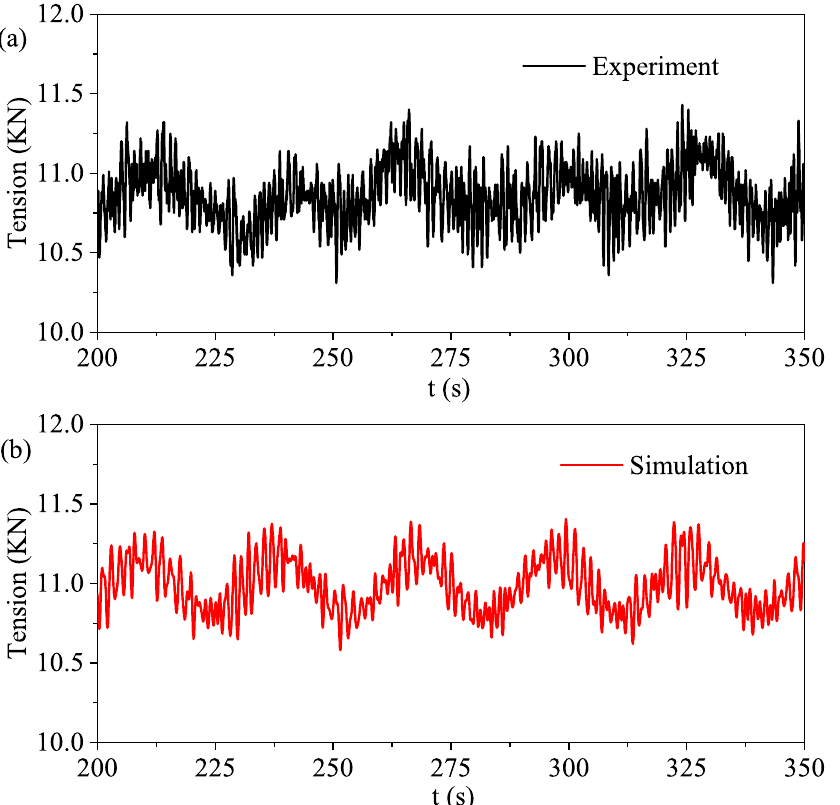
Figure 16. The instantaneous experimental and simulation mooring tension in the port bow moor- ing line: ( a ) mooring tension from the experimental results; ( b ) mooring tension from the simulation